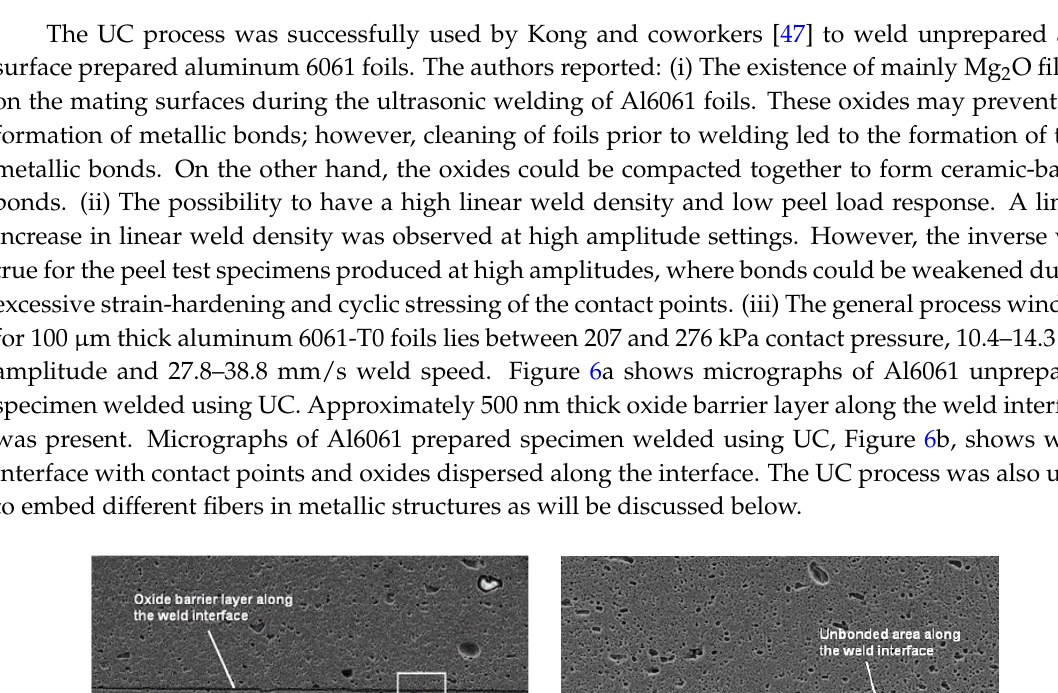
Figure 5. ( a ) Front view and ( b ) embedding features of ultrasonic consolidation process [40].